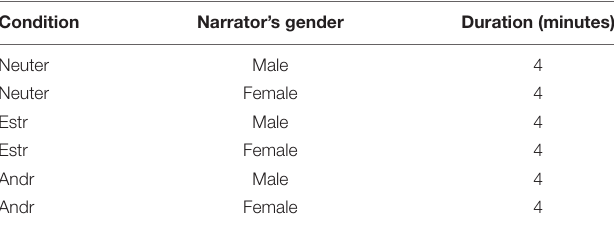
TABLE 1 | Storytelling conditions, narrator’s voice, and duration of the storytelling